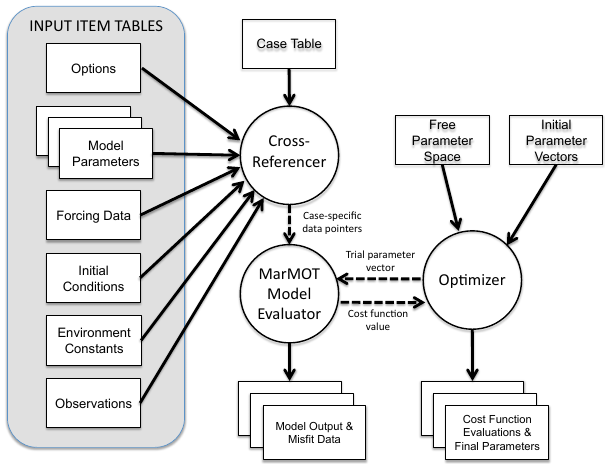
Fig. 1. Simplified schematic of the MarMOT system, showing the